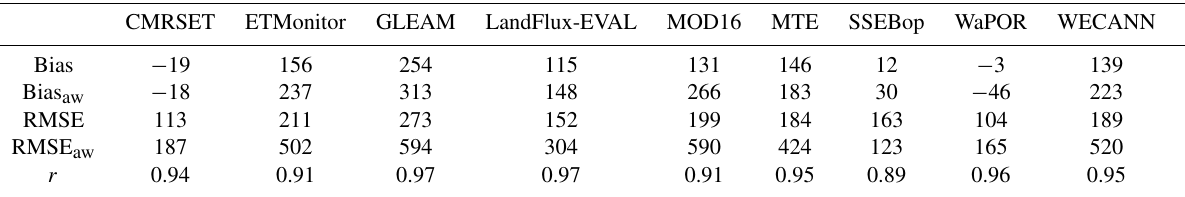
Figure 9. Evaluation of the calculated ET WB and ET RS from products using the Budyko curve calculated using the average P and PET from three products. Table 7. Calculated statistics, including the bias, bias aw , RMSE, RMSE aw and r , for the comparison of the long-term annual average ET WB with ET RS